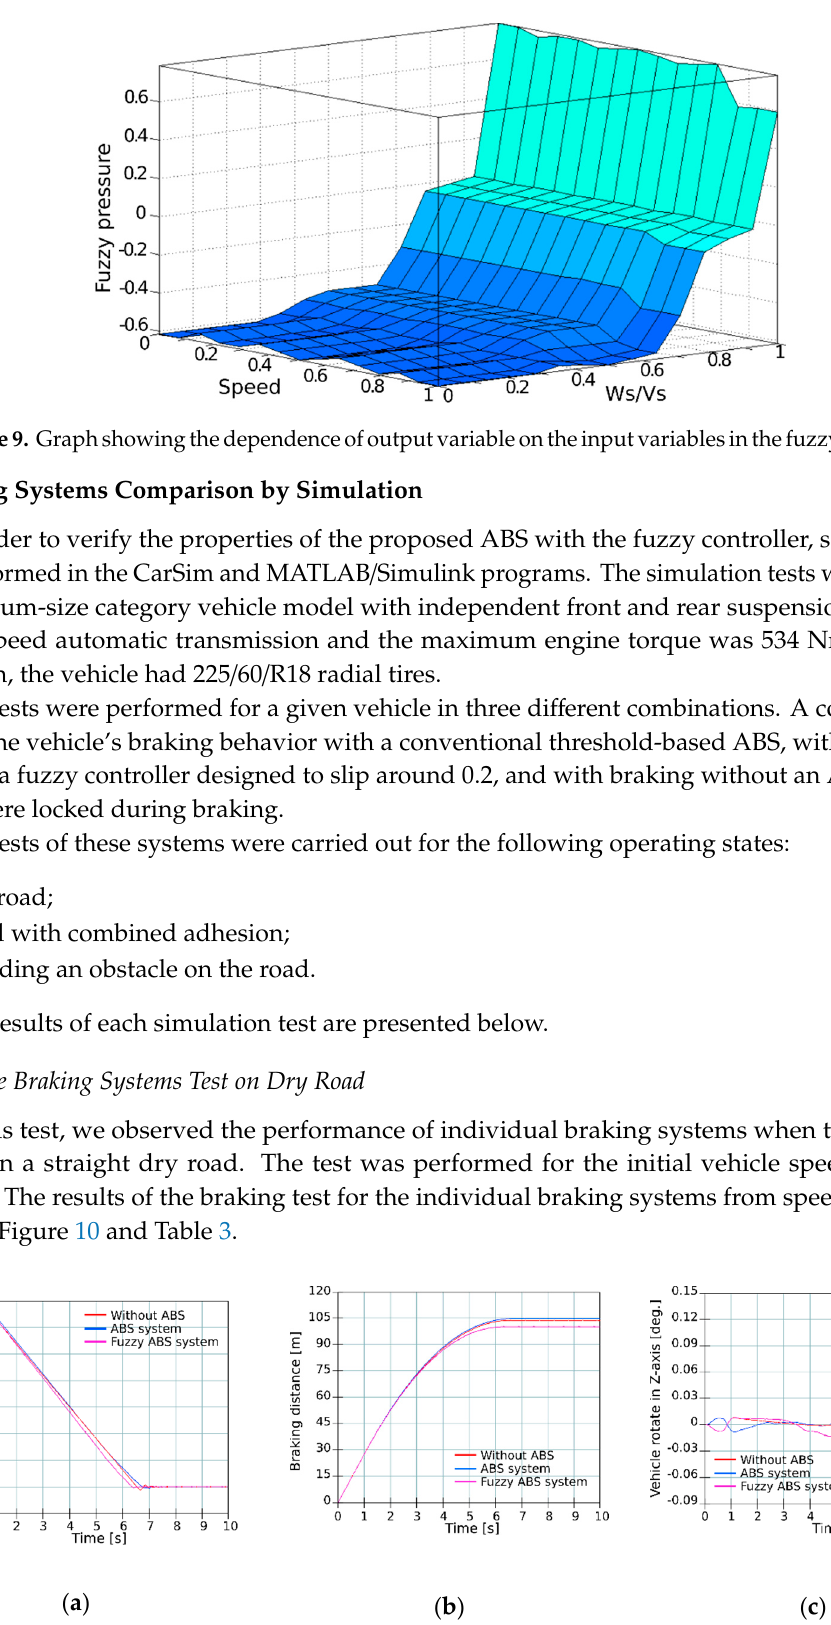
Figure 8. Setting rules of FIS matrix for fuzzy controller.